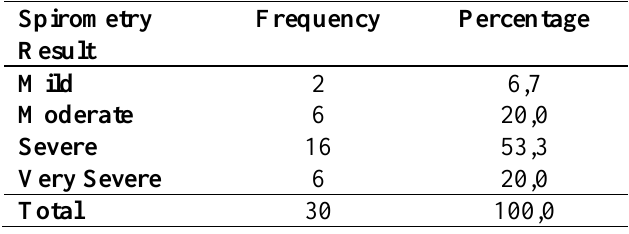
Table 4. Spirometry